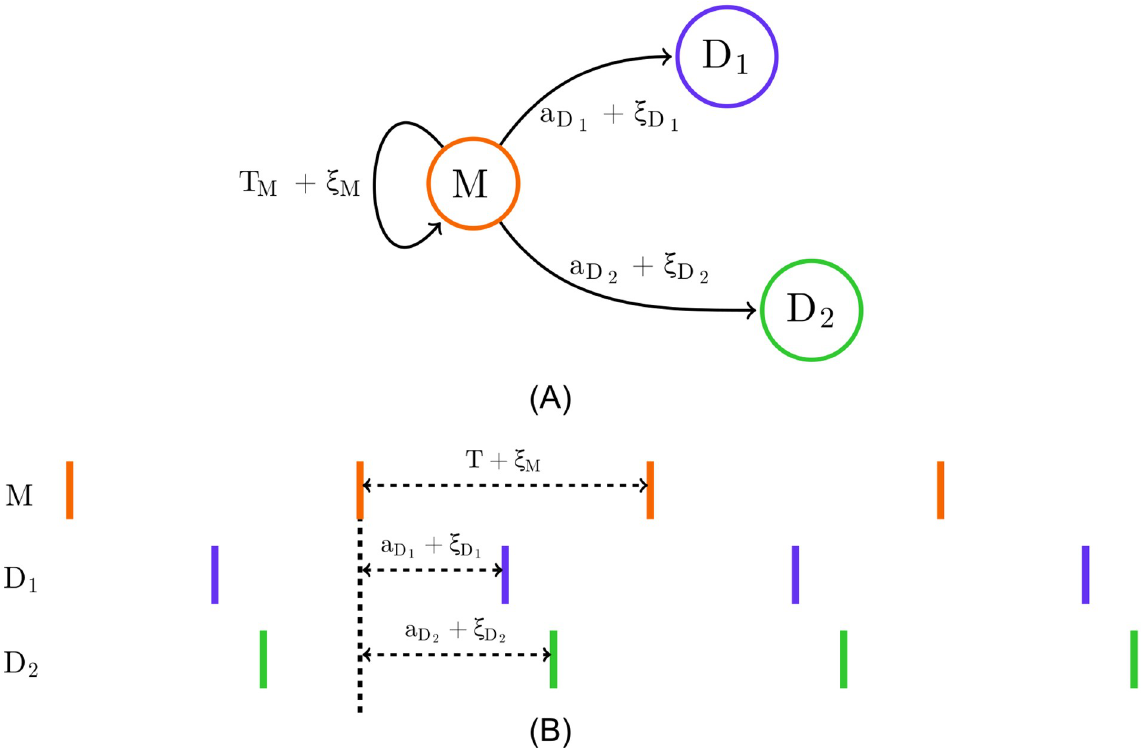
Fig 5. Diagram of the noisy copy process. Events in the mother process M occur periodically with intervals T + ξ terms). Events in the daughter processes D 1 and D 2 occur after each event in the mother process, at a distance of a shows a graph of the dependencies with the labels on the edges representing delays. (B) shows a diagram of a representative spike raster.